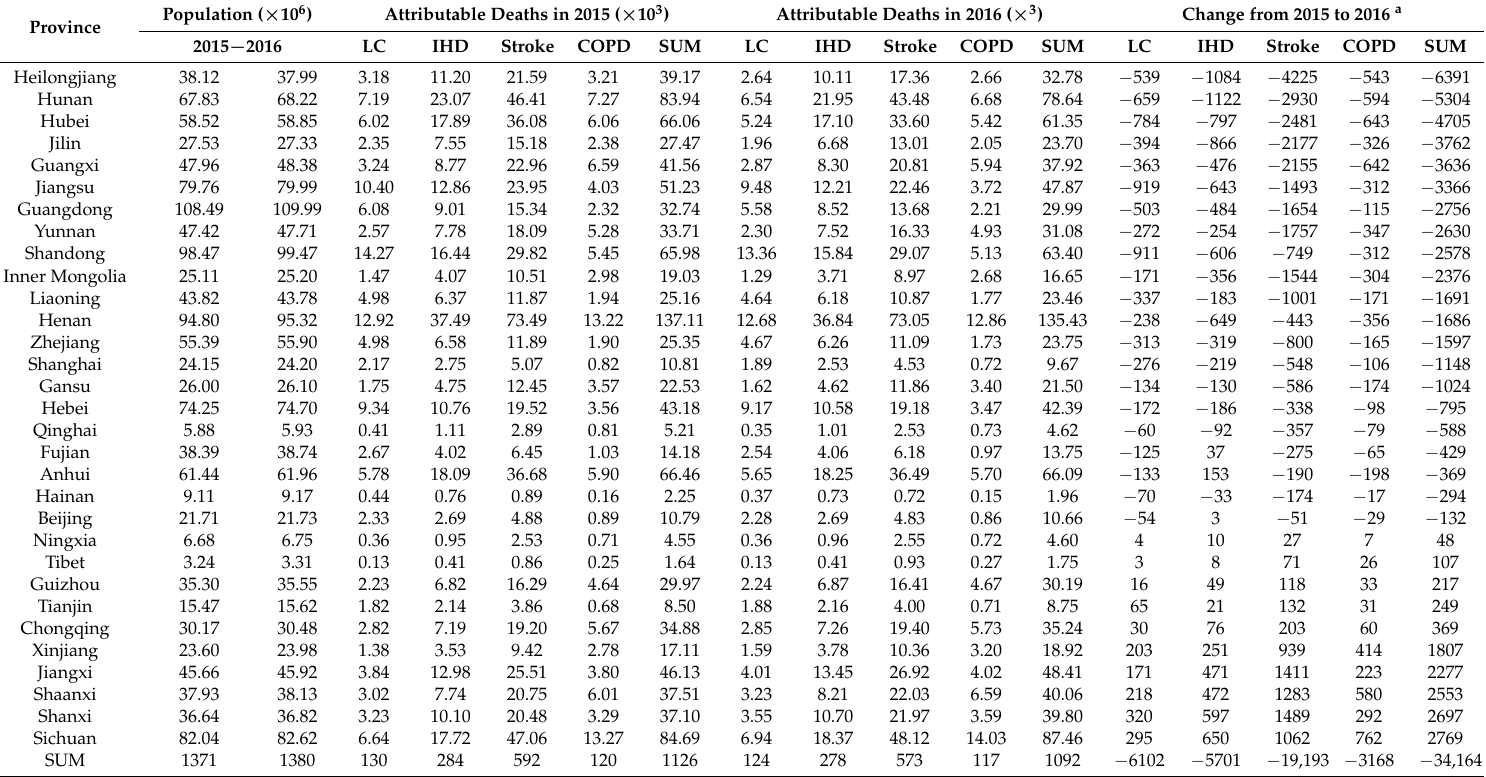
Table 1. Changes in deaths due to exposure to PM 2.5 at the provincial